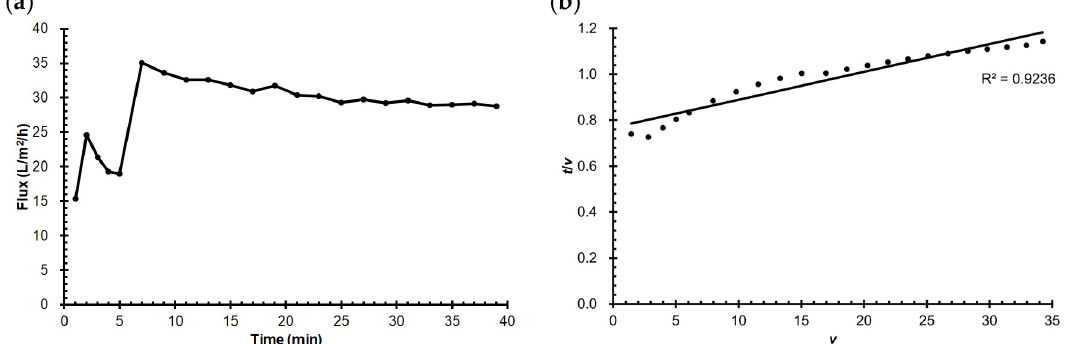
Figure 2. ( a ) Evolution of membrane flux during the concentration of model milk; ( b ) Fi(cid:308)ing of per- meate volume ( v ; L) and filtration time ( t ; min) during the UF of model milk to Hermia’s